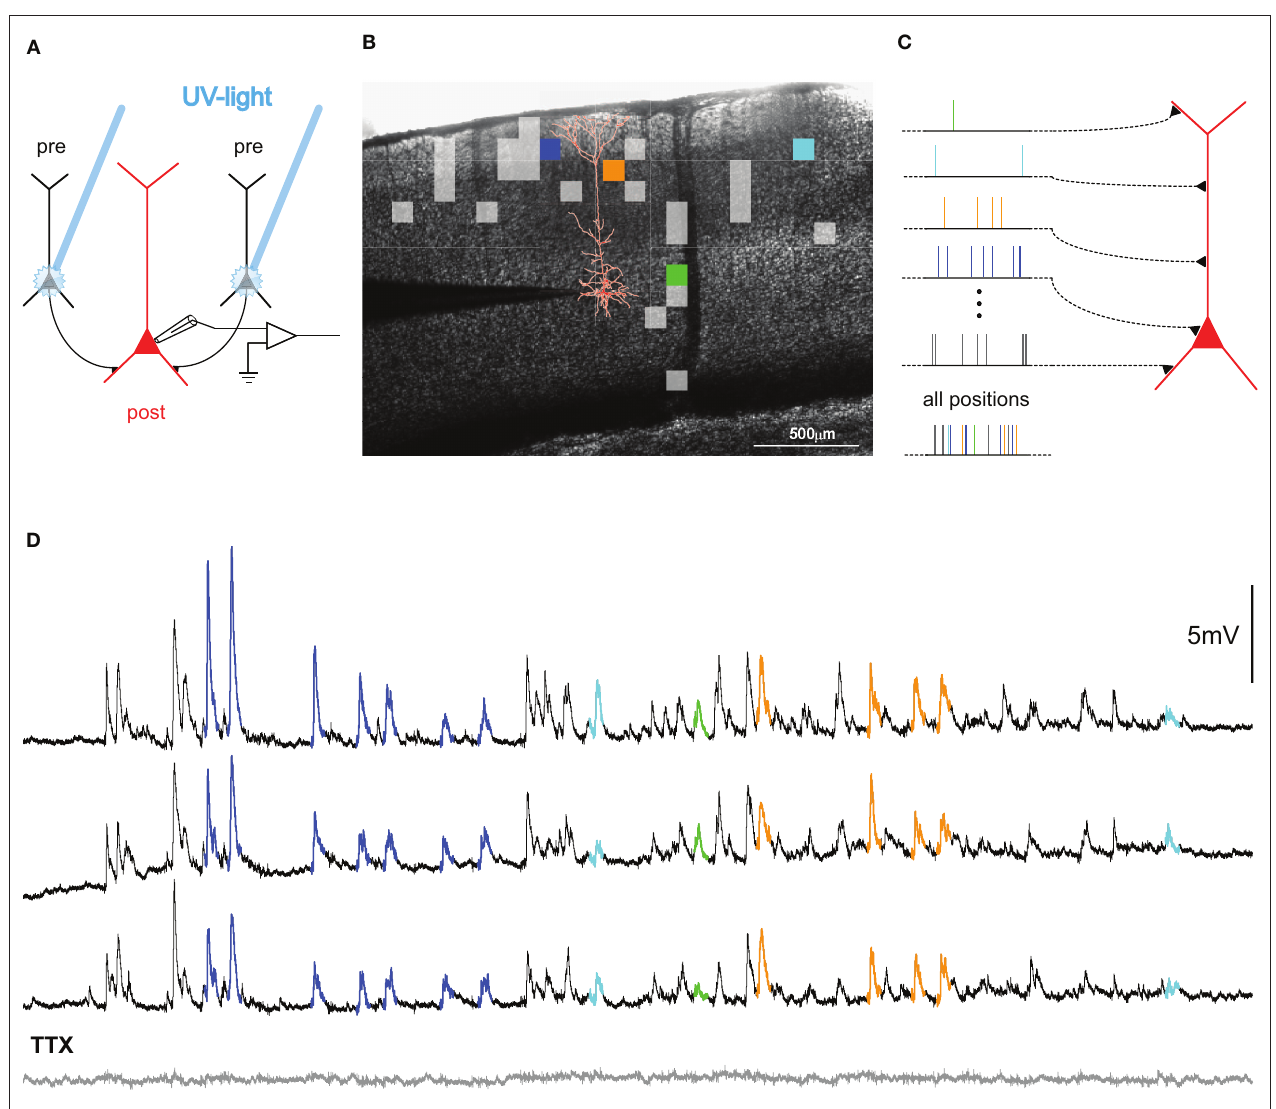
Using the fast DPS-system (Boucsein et al., 2005; Nawrot et al., 2009), presynaptic neurons can be activated dynamically to produce patterns of spatiotemporal synaptic input to the postsynaptic cell (red). (D) Dendritic integration in the postsynaptic neuron. Three repetitions of the same stimulation sequence (tics, bottom) resulted in repeated sub-threshold membrane potential fluctuations. Voltage traces for selected presynaptic sites are colored for the first 80 ms following presynaptic photostimulation, corresponding to the sites, indicated in (B,C) . Note the remarkable reproducibility of the voltage fluctuations across trials. The gray trace shows the response to the same stimulation after application of TTX, confirming the purely synaptic origin of the recorded